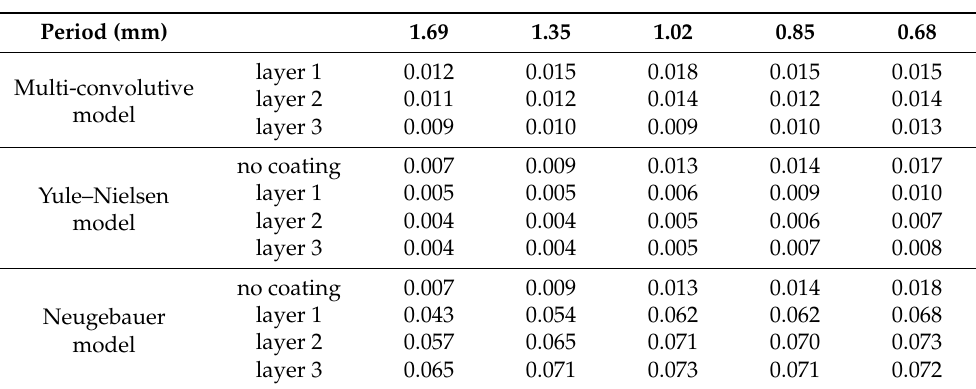
Table 2. Root mean square error between the models and the